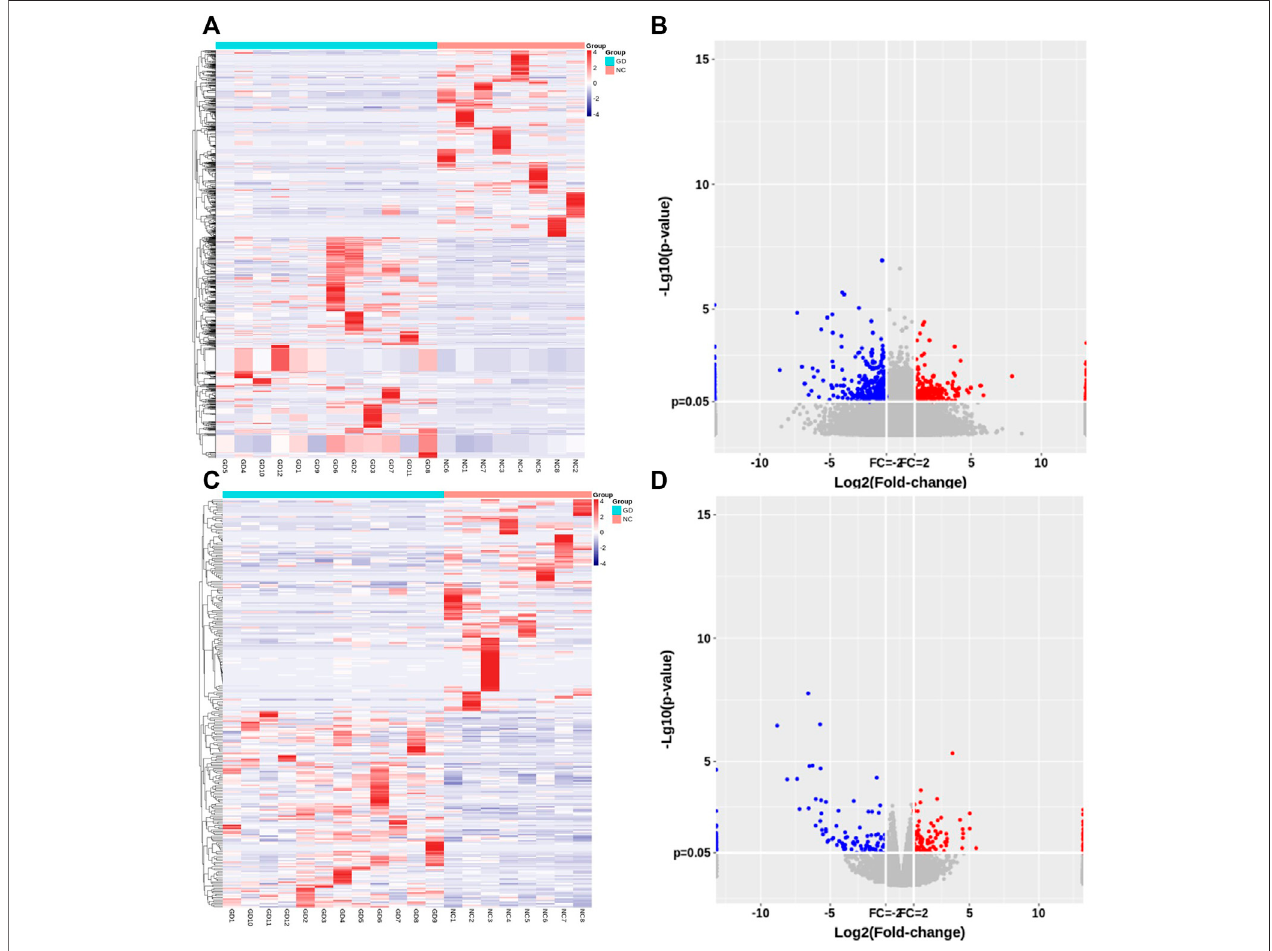
FIGURE 1 | Expression pro fi le of lncRNAs and mRNAs in CD4+ T cells of relapsed GD patients. (A) Hierarchical clustering of differentially expressed lncRNAs between GD group ( n (cid:1) 12) and normal controls (NC) ( n (cid:1) 8). (B) Volcano plots of lncRNA expression levels between two groups. (C) Hierarchical clustering of differentially expressed mRNAs between GD group ( n (cid:1) 12) and normal controls (NC) ( n (cid:1) 8). (D) Volcano plots of mRNA expression levels between two groups. Each columnrepresentsasample,andeachrowindicatesonegene.Redindicatesthosegeneswithrelativelyhighexpressionlevel,andblueindicatesthosegeneswith relatively low expression